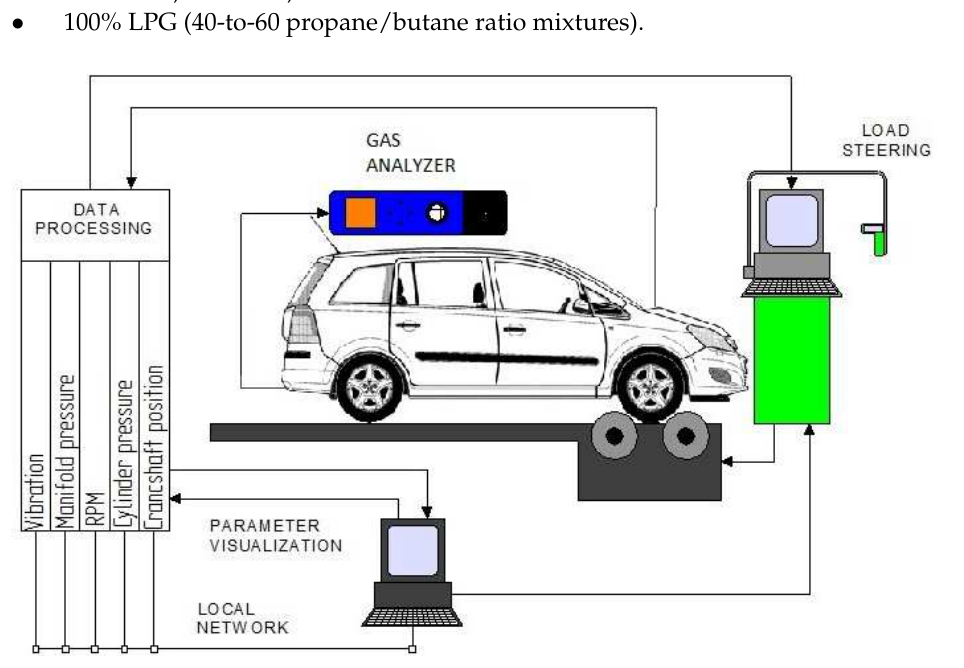
Figure 2. Test bench diagram [26].